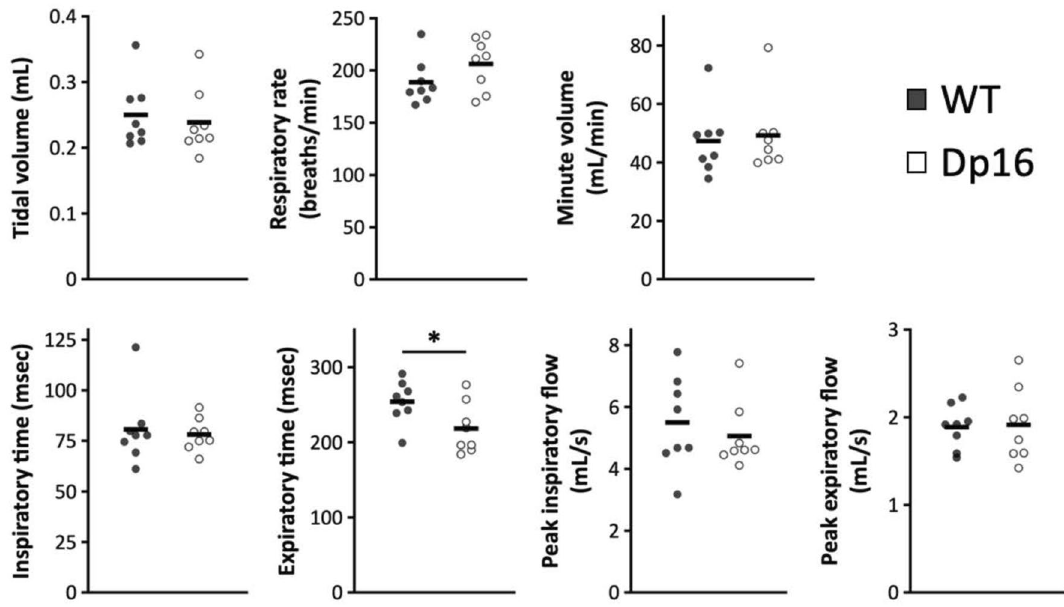
Figure 1. Comparison of respiratory parameters obtained using whole-body plethysmography. Seven parameters were obtained from plethysmography. Values are presented as means ± SD. * P <